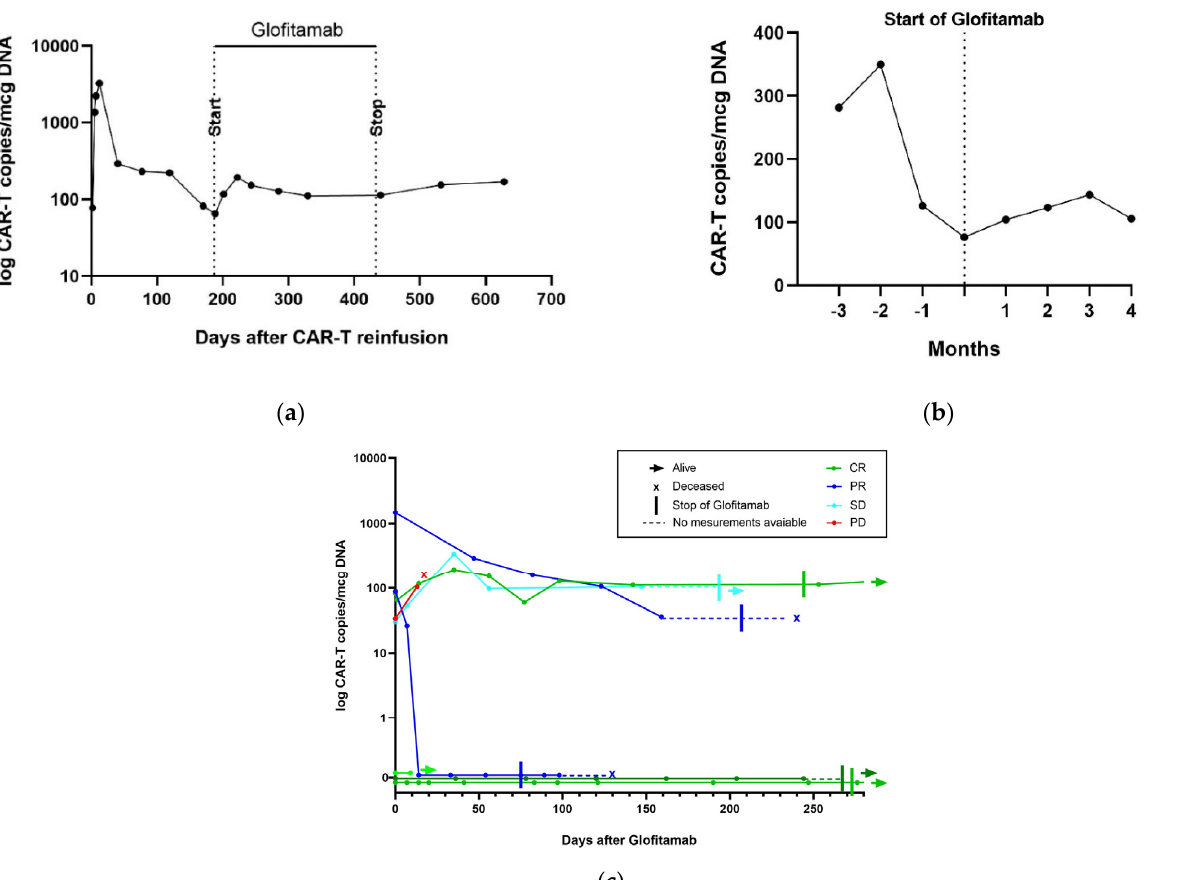
Figure 4. CAR T-cell expansion during glofitamab therapy. ( a ) CAR T-cell copies/mcg DNA in one patient who had CR and experienced a re-expansion of CAR T-cells after glofitamab; ( b ) median CAR T-cell copies/mcg DNA before and after glofitamab in all patients who had measurable CAR T-cells; ( c ) CAR T-cell copies/mcg DNA for each patient after the administration of glofitamab.